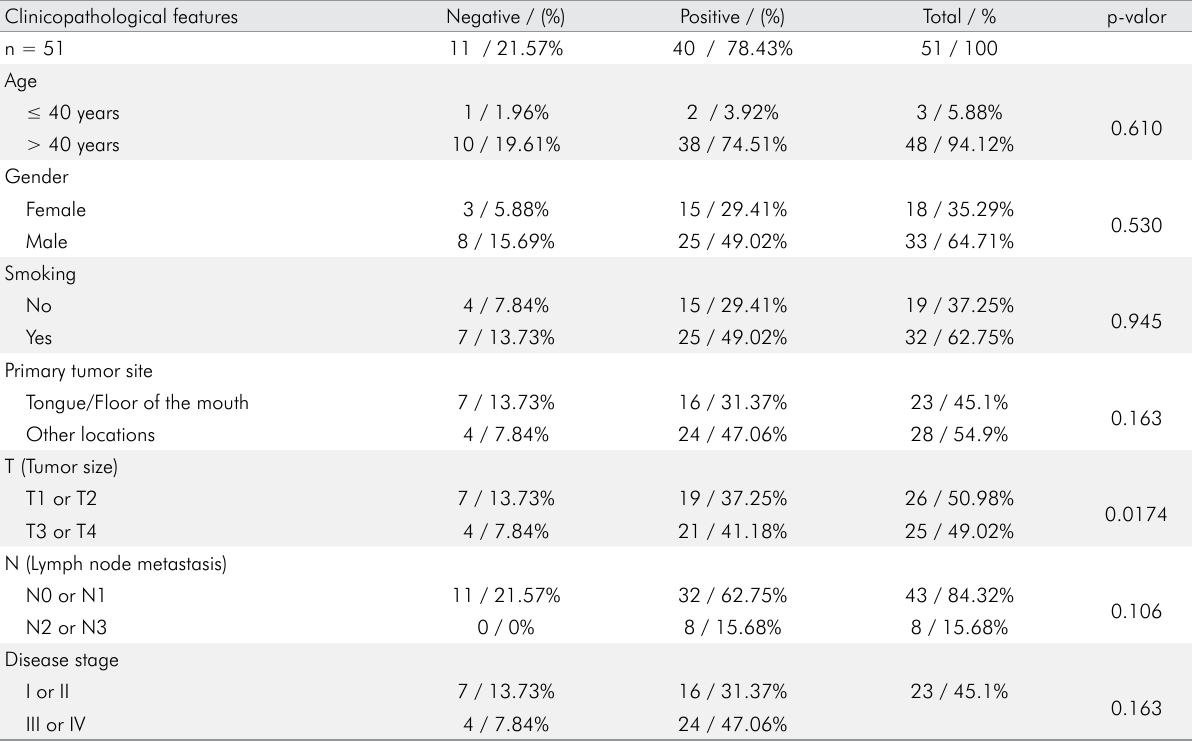
Table 1. Association between Ki67 immunostaining and clinicopathological characteristics.